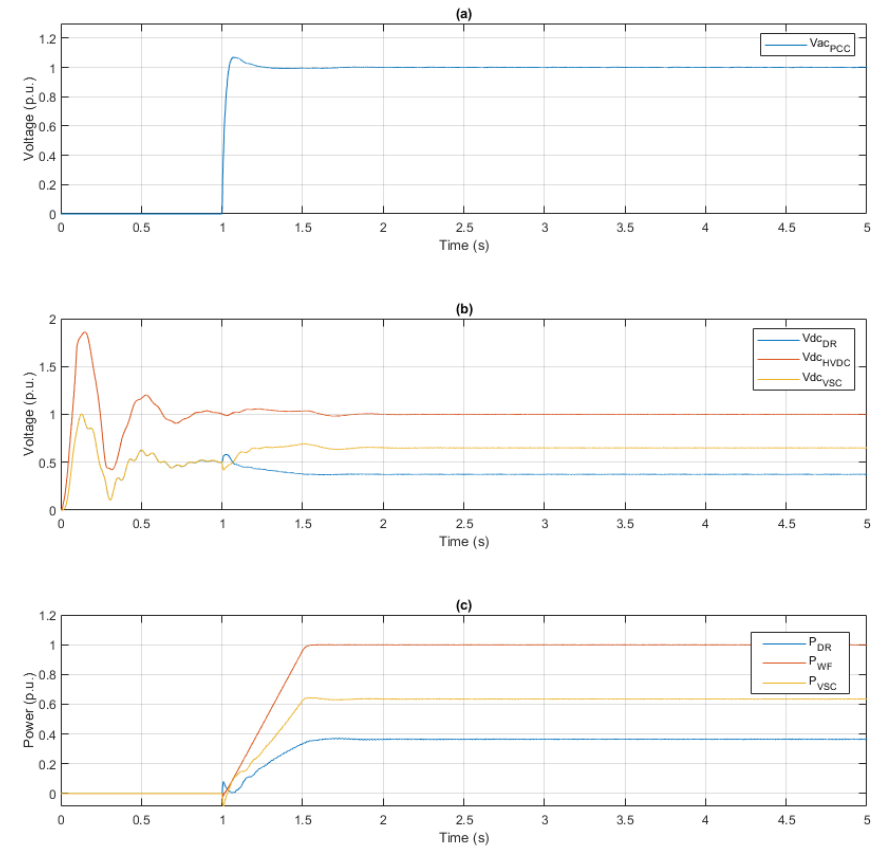
Figure 6. ( a ) Offshore voltage magnitude at the point of common coupling (PCC), ( b ) DC voltage of HVDC and hybrid converter, ( c ) converters’ active power.